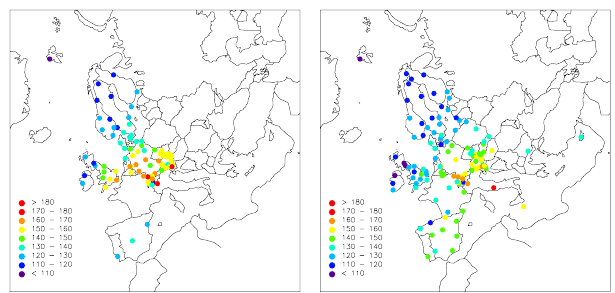
Fig. 15. Ten years mean of the annual 99 percentiles ( p 99 ) based on hourly data from the summer half year (April–September) for the years 1990–1999 (left) and 2000–2009 (right). Unit: µgm − 3